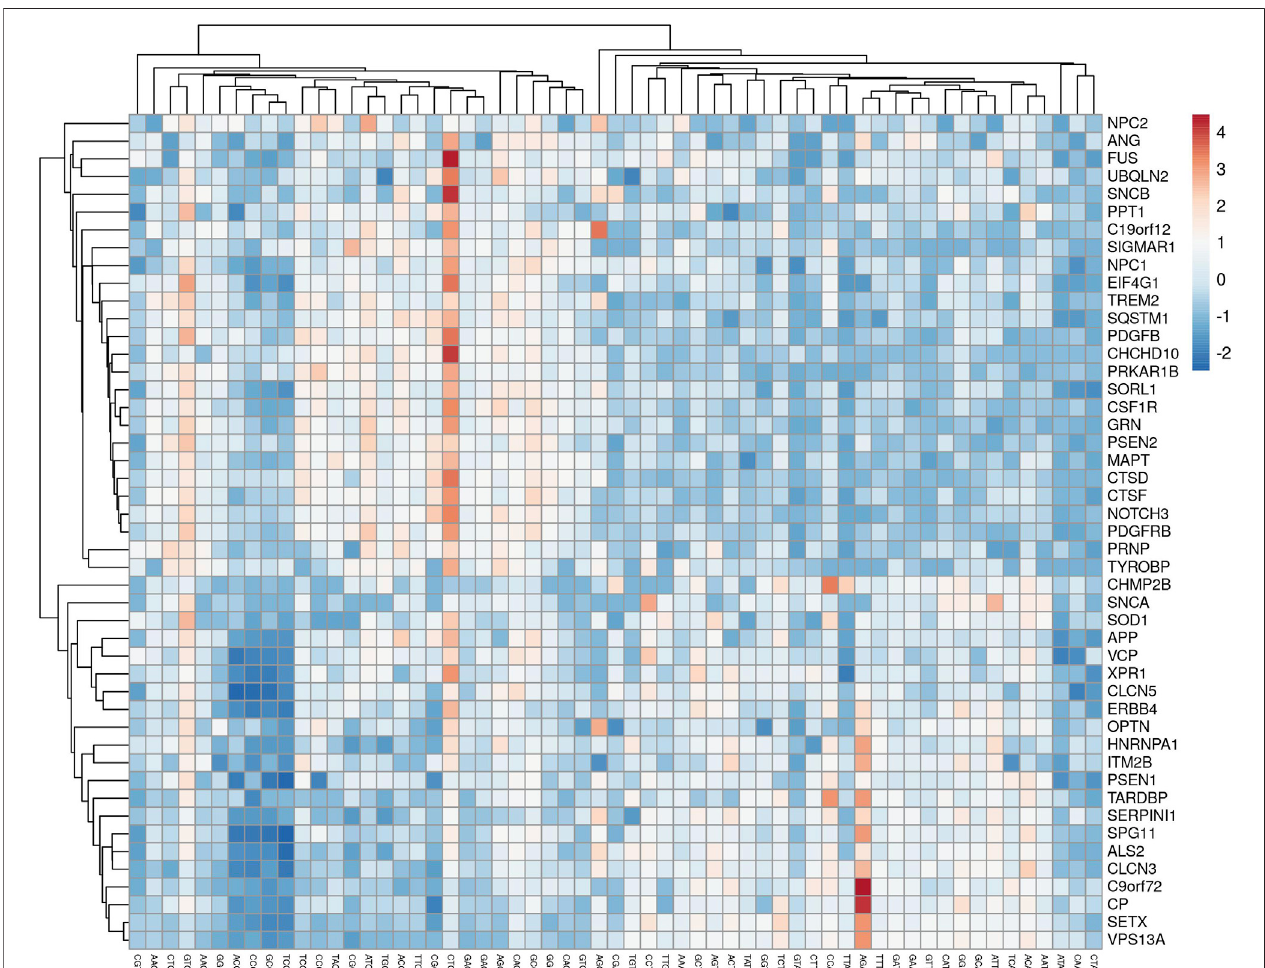
FIGURE 3 | A cluster analyses of multivariate data showed the clustering of TTG with AT-ending codons.